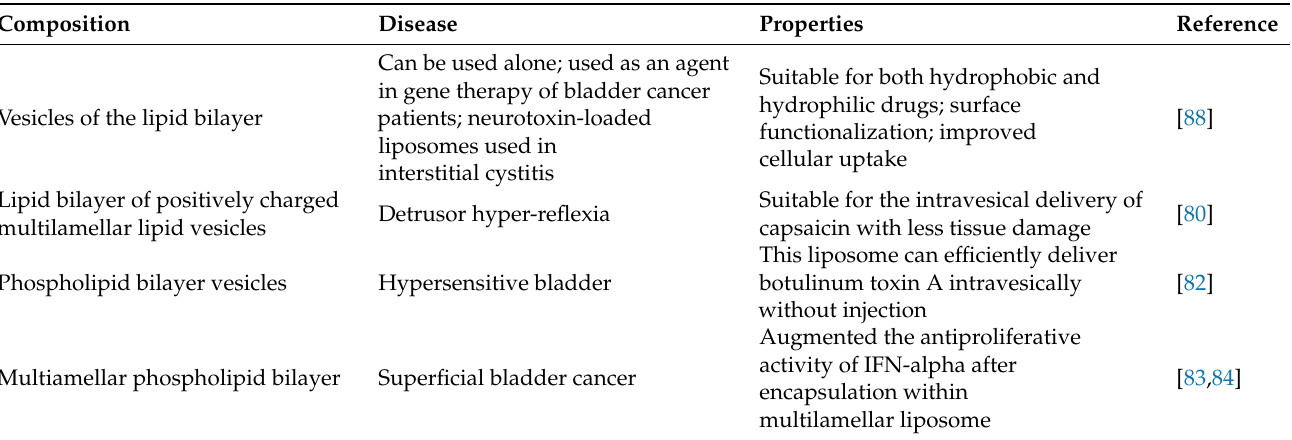
Table 2. Liposome-based delivery systems employed in IDD along with their general characteristics, composition, size and uses in various